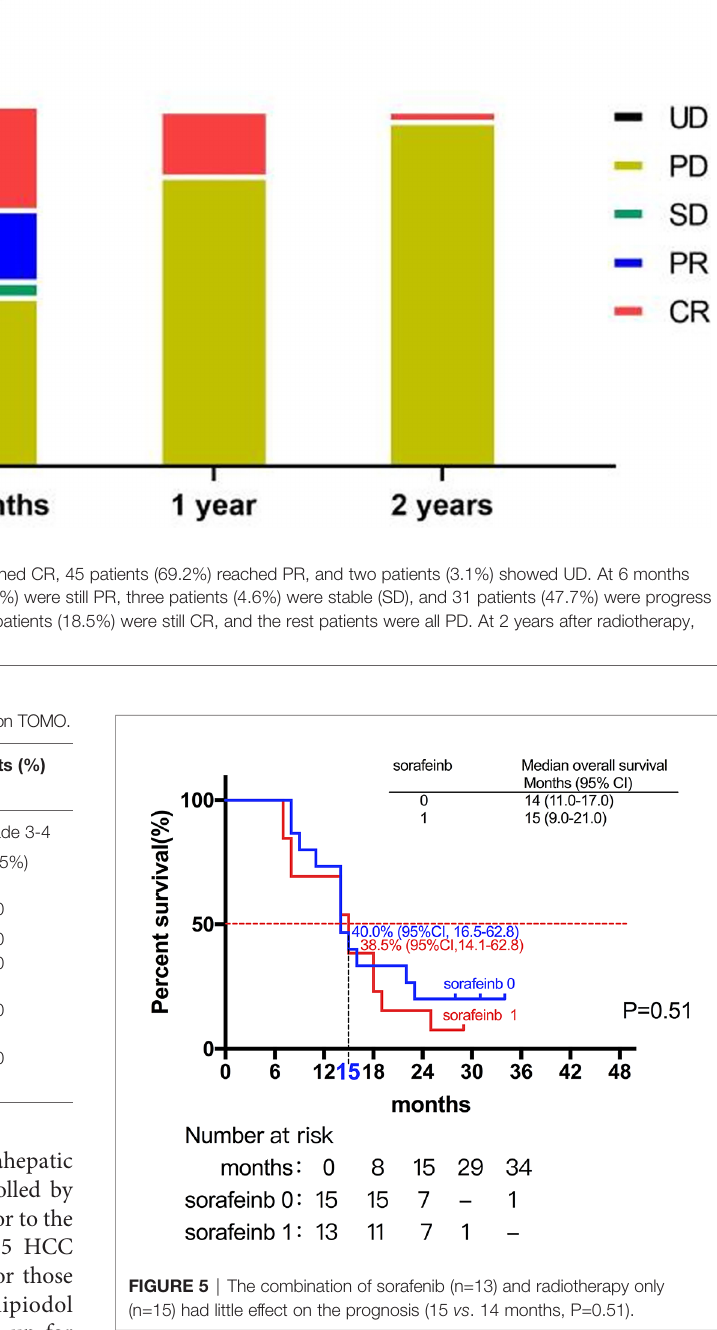
FIGURE 5 | The combination of sorafenib (n=13) and radiotherapy only (n=15) had little effect on the prognosis (15 vs . 14 months, P=0.51).